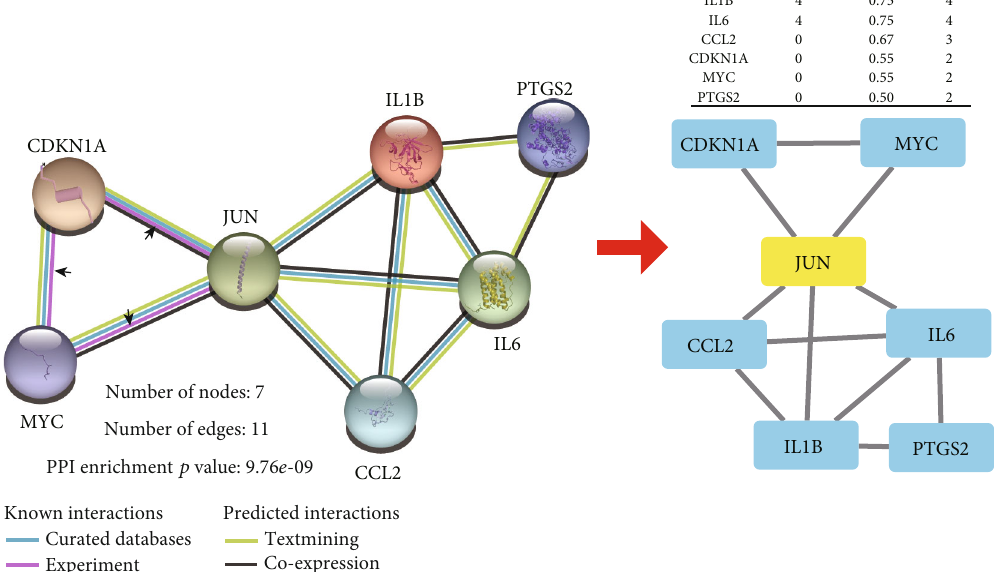
Figure 5: “ Protein – protein interaction ” network. JUN is the hub gene of this protein interaction network, and it has an exact protein interaction relationship with CDKN1A and